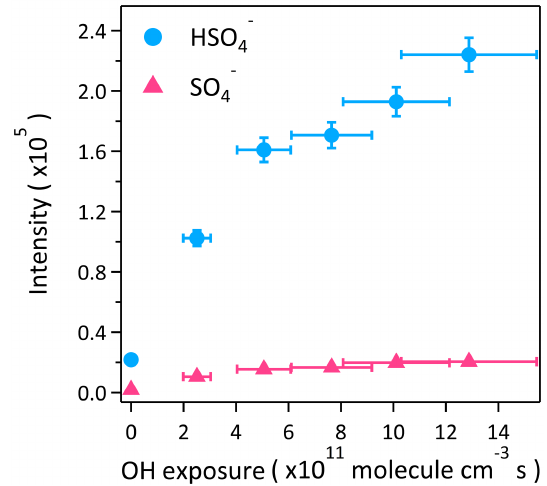
Figure 6. The normalized parent decay of sodium ethyl sulfate as a function of OH exposure in the heterogeneous OH oxidation.